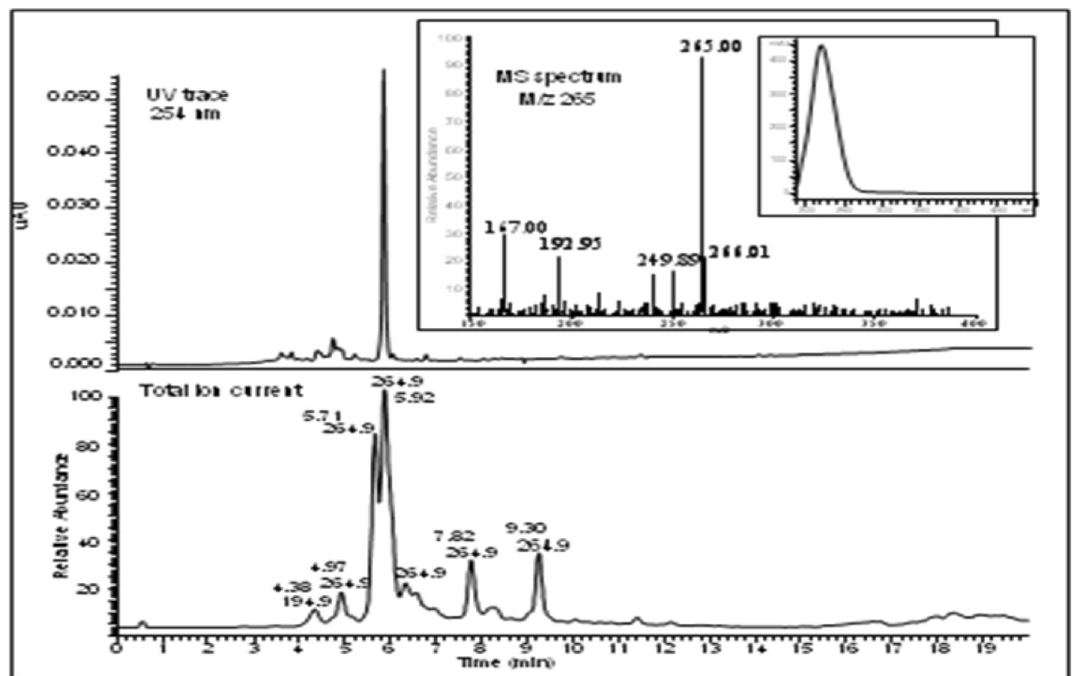
Fig. 1 LC/APCI-MS analysis of the active